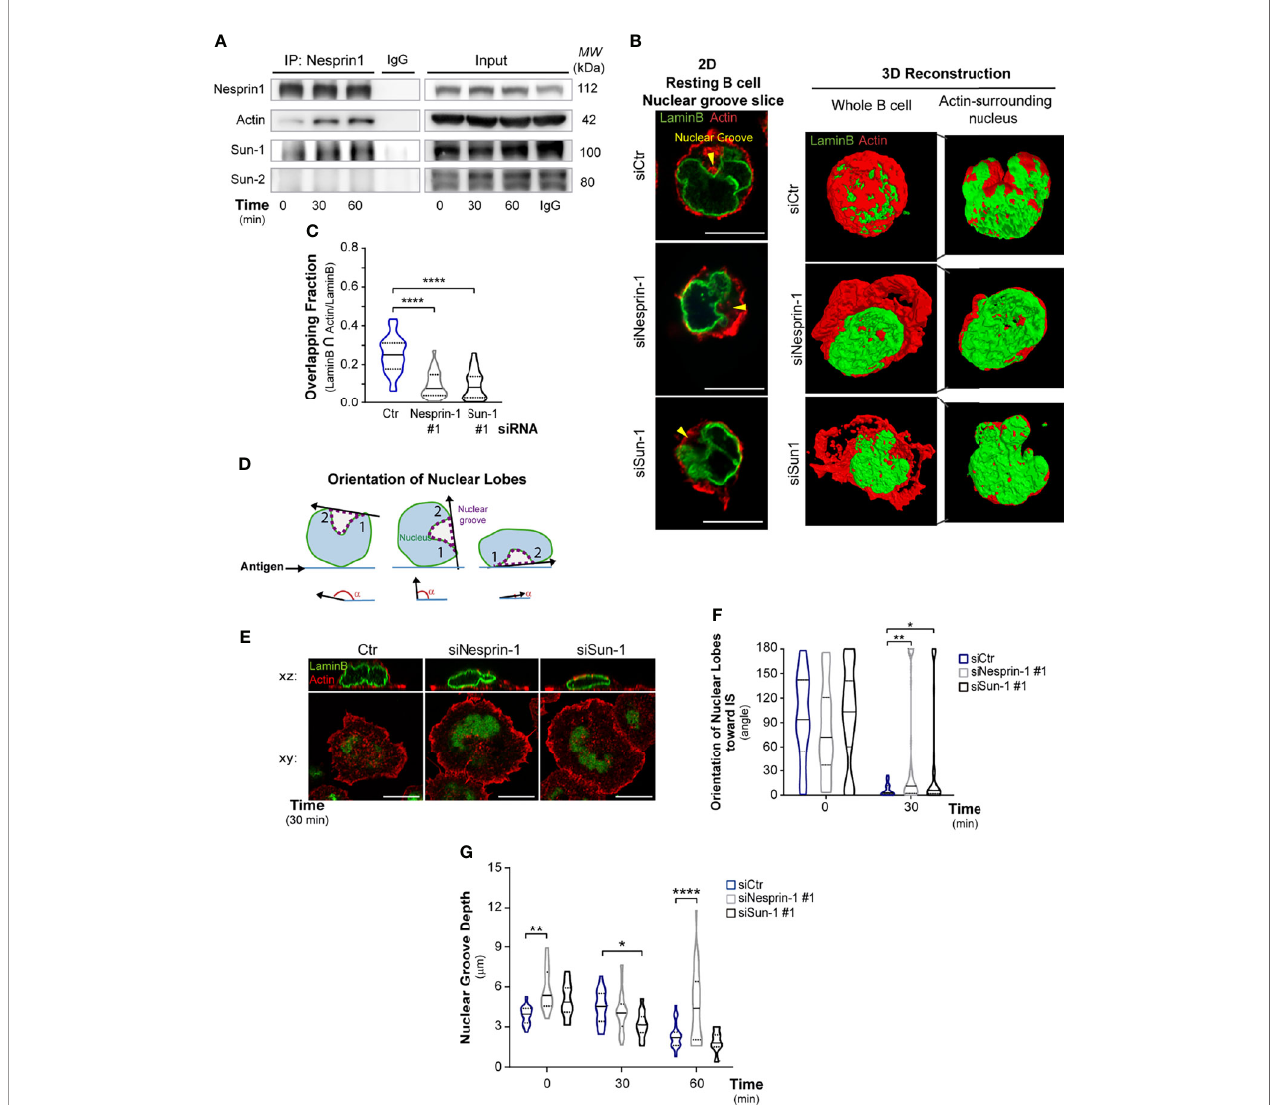
FIGURE 3 | Nesprin-1 and Sun-1 regulate nuclear shape during B cell activation. (A) Nesprin-1 immunoprecipitation (IP) assay to detect LINC complex (Nesprin-Sun) formation in resting or activated B cells for indicated times; data represent three independent experiments. (B) Left: Representative confocal images of nuclear groove slice in control, Nesprin-1-, and Sun-1-silenced B cells under resting conditions. Scale bar: 10 m m. Right: 3D reconstruction images showing whole B cells (total volume of actin and Lamin B); and logical fi lter applied on actin signal, showing only actin surrounding the nucleus. (C) 3D measurement of the intersections between actin and Lamin B by segmented signals. Quanti fi cation of the ratio of intersection of Lamin B and the actin signal divided by the total lamin B signal; n ≥ 48. (D-F) Measurement of nuclear groove rotation in Nesprin-1-, and Sun-1-de fi cient B cells. Controls and silenced cells were incubated on antigen-coated dishes for indicated times. Scheme depicting the method used to measure nuclear orientation towards the synaptic plane (D) , representative confocal images (E) , and quanti fi cation of complete nuclear lobes rotation (F) between 180° – 0°; n ≥ 60 cells from two independent experiments. (G) Quanti fi cation of the nuclear groove depth (height) in control, Nesprin-1-, and Sun-1-silenced B cells under resting and activating conditions. n ≥ 55. Lamin B: green; actin: red in all images. Statistical analyses: Kruskal-Wallis with Dunn ’ s multiple comparisons tests (C) and two-way ANOVA with Sidak ’ s multiple comparison tests (F, G) ; *p < 0.05, **p < 0.01, and ****p <